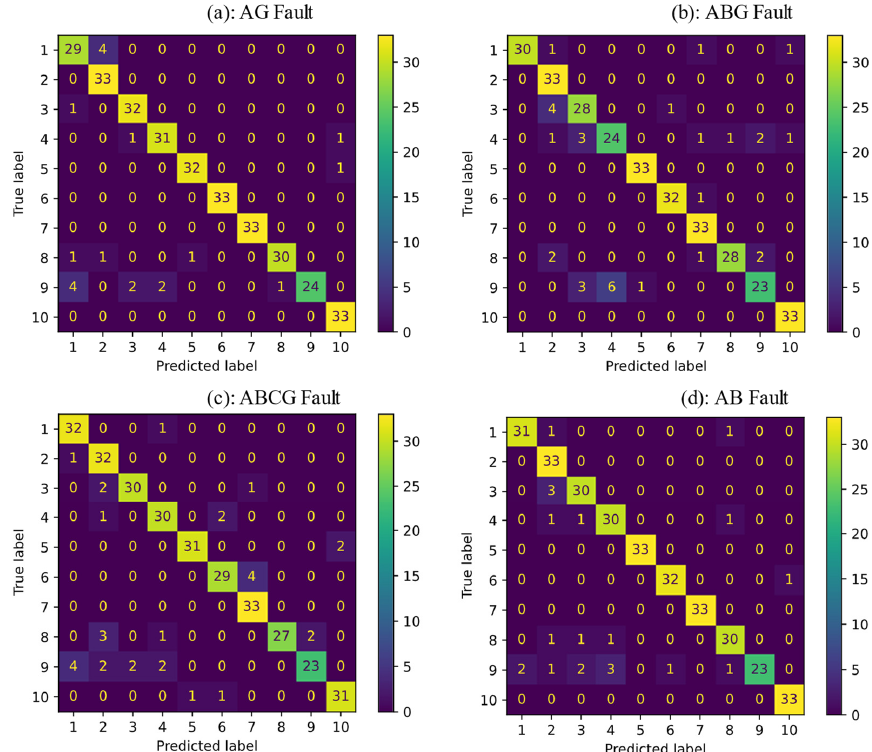
Figure 10. The confusion matrix for four types of faults using KNN, ( a ) Single-phase to ground fault, ( b ) Two-phase to ground fault, ( c ) Three-phase to ground fault, ( d ) Phase-to-phase fault.